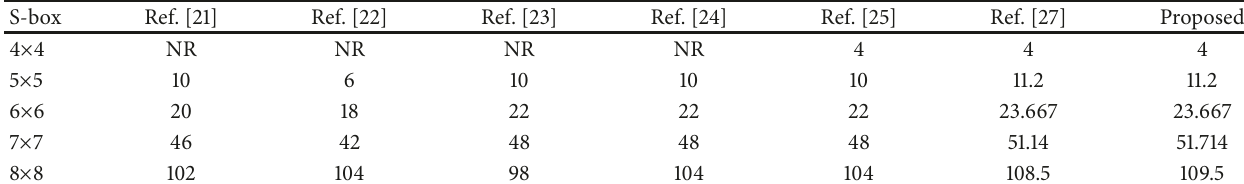
Table 18: Comparison of average nonlinearities of small-sized